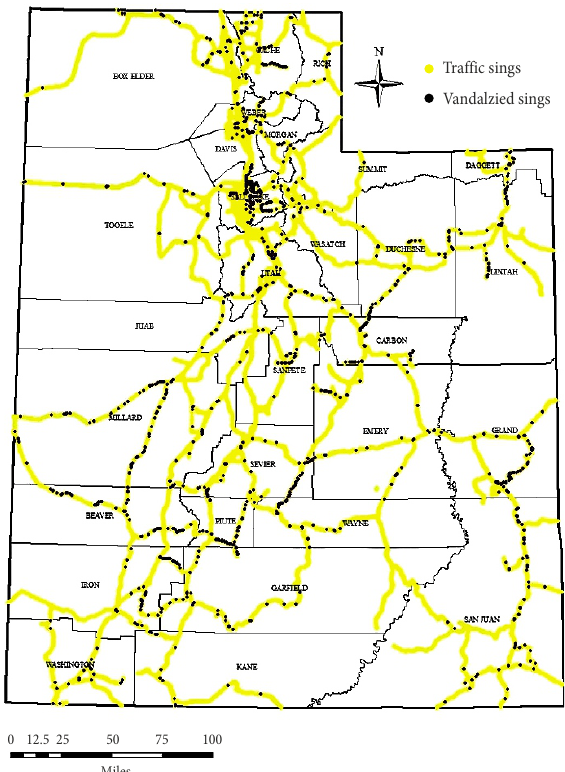
Fig. 3. Locations of vandalized traffic signs in